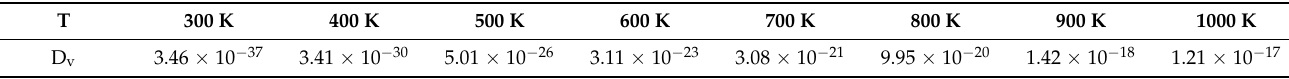
Table 3. The diffusivity of vacancies in W at a temperature range of 300 K to 1000 K. T 300